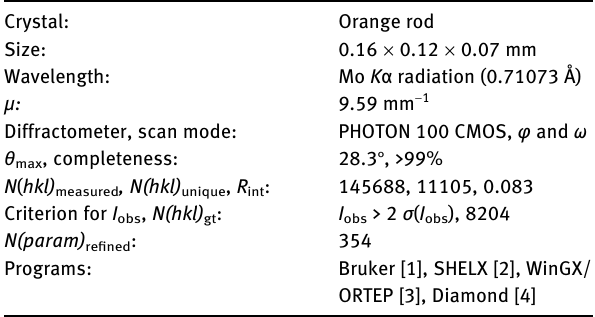
Table 1 contains crystallographic data and Table 2 contains the list of the atoms including atomic coordinates and displacement parameters.